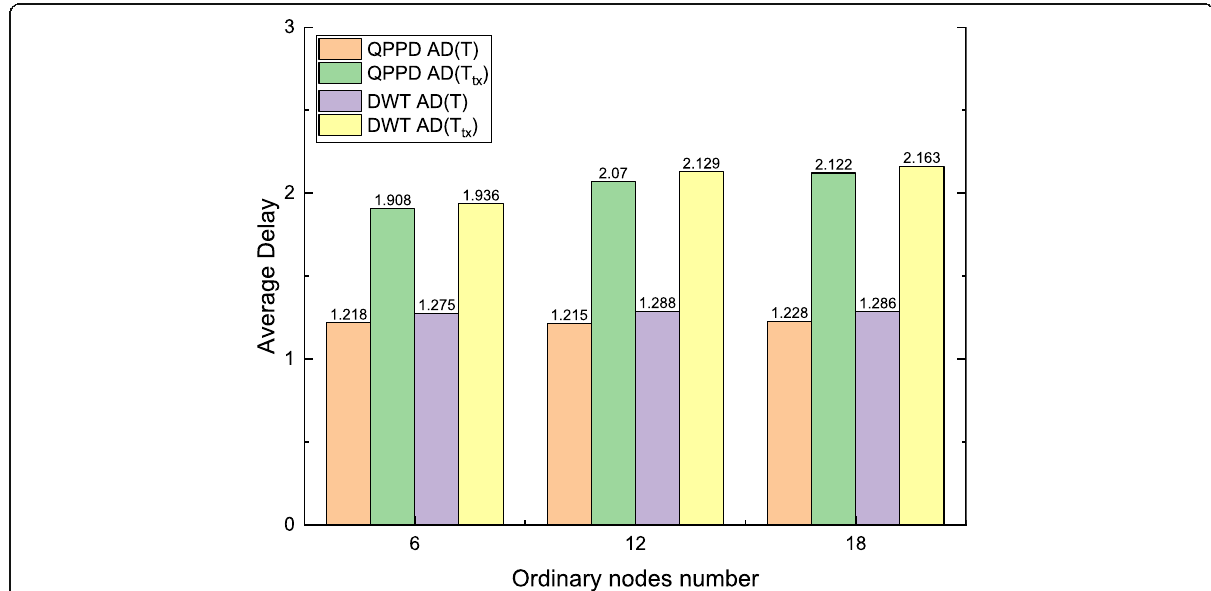
Fig. 23. The average delay of high priority packets is greater for the former in this case. When the total